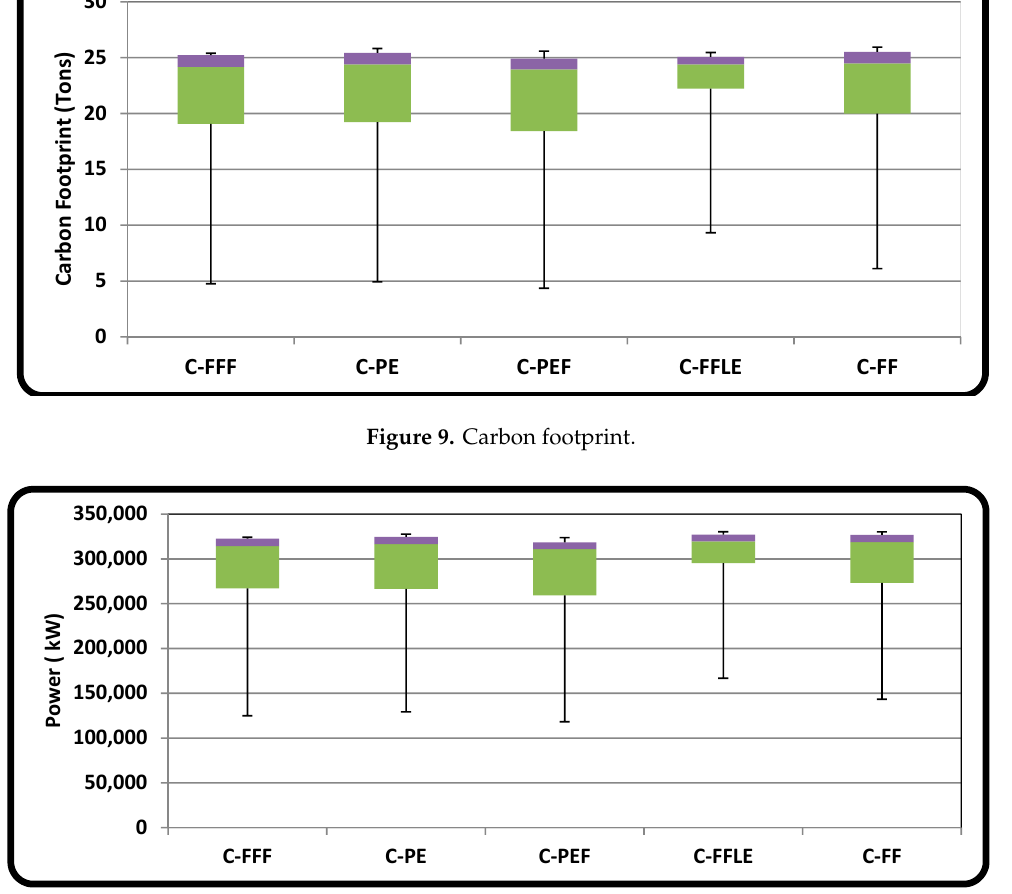
Figure 10. Power consumption.